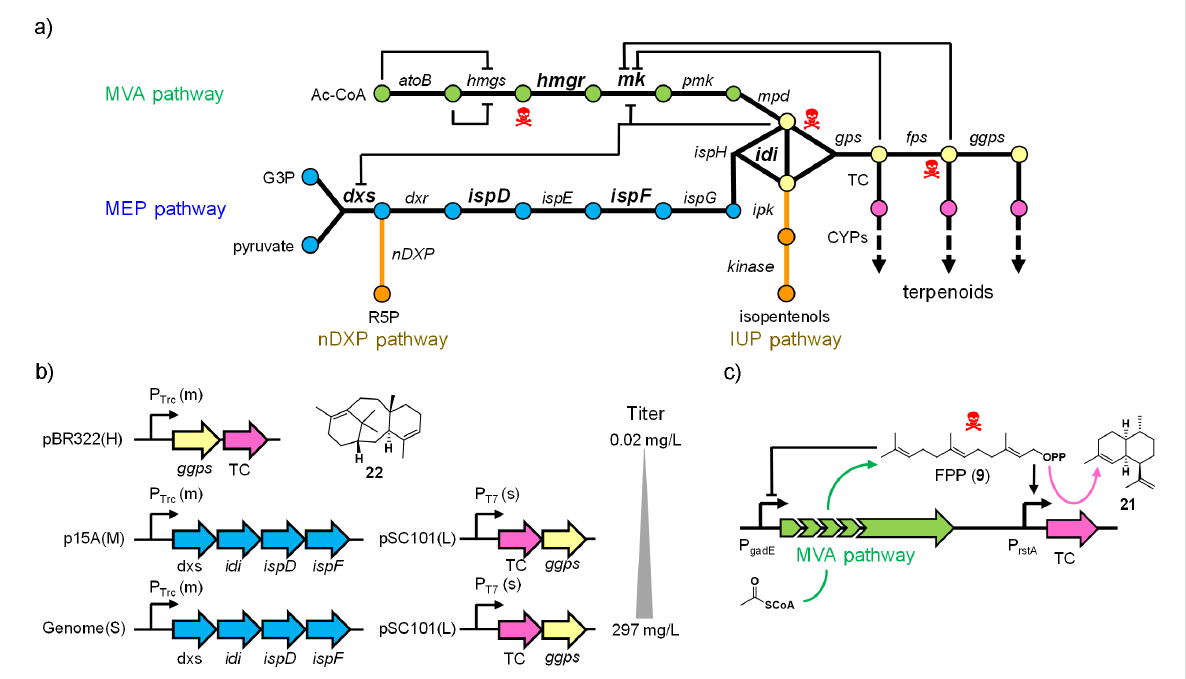
Figure 11: Engineering of terpenoid pathways. a) Metabolic network of terpenoid biosynthesis. Toxic intermediates are labeled with skull signs and known enzyme inhibition by intermediates is indicated. Bottleneck enzymes that have been subjected to optimization/engineering are highlighted in bold. Two novel pathways, nDXP and IUP, provide alternative entry points to terpenoid biosynthesis. b) Balancing gene expression for taxadiene ( 22 ) production in E. coli . The copy number of the constructs are labeled with upper case letters: H: high, M: medium, L: low, and S: single copy. The rela- tive strength of the promoter is labeled with lower case letters: s: strong and m: medium. This tuning led to 15,000-fold increase in taxatidene titer. c) Two FPP ( 9 )-responsive promoters were implemented to dynamically control the expression of MVA pathway genes and the terpene cyclase gene in order to prevent the accumulation of toxic FPP ( 9